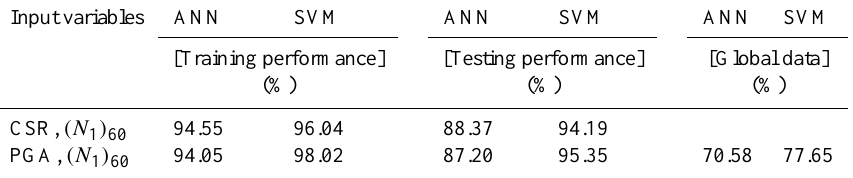
Table 1. Comparison between ANN and SVM